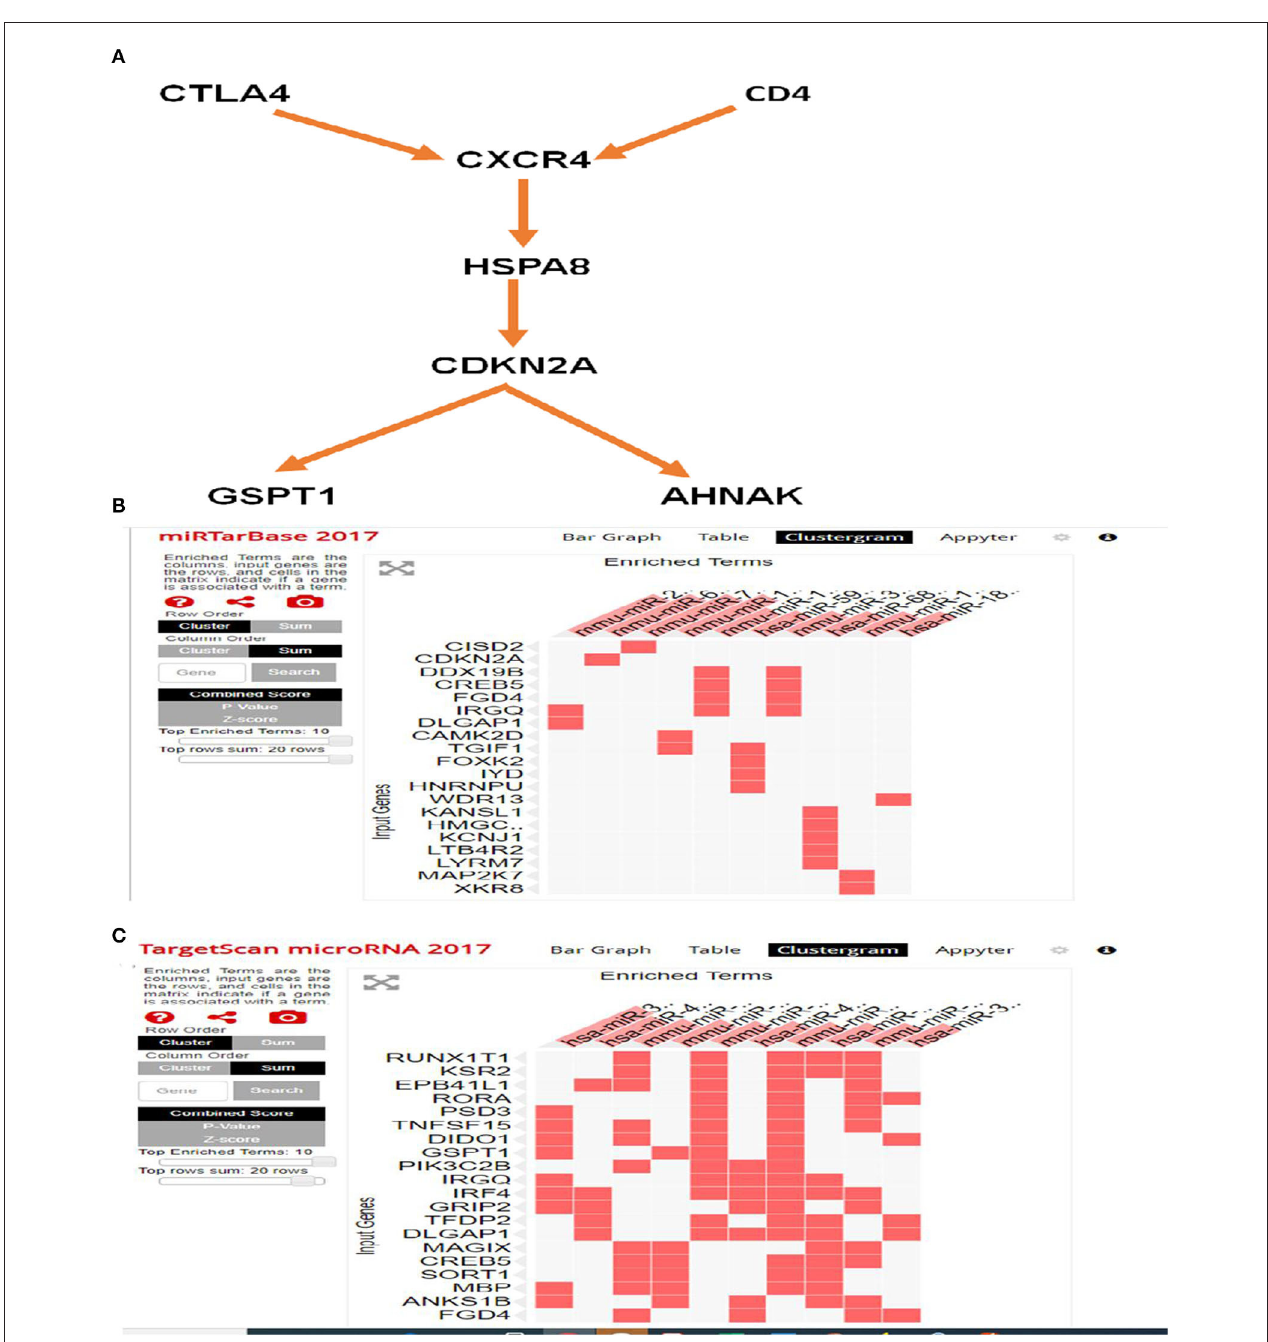
FIGURE 8 | Interactome and miRNA target analysis using FUNRICH and EnrichR. (A) Major pathway includes CTLA4, CDKN2A, and HSPA8 involves cell cycle, apoptosis, and autophagy pathway. (B) Target miRNA analysis by miRTarbase that identifies CISD2 and CDKN2A. (C) Target miRNA analysis by targetmiRNAScan identifies RUNXIT1 and